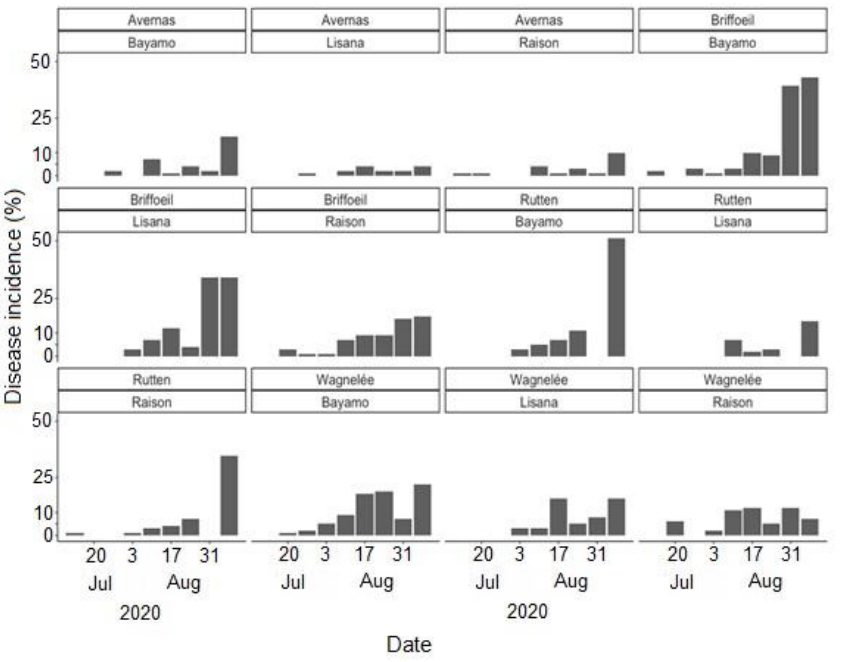
Figure 6. Observed incidence of Cercospora leaf spot at Avernas, Briffoeil, Rutten, and Wagnelée, Belgium, during the 2020 cropping season. Three different cultivars were monitored at each site.